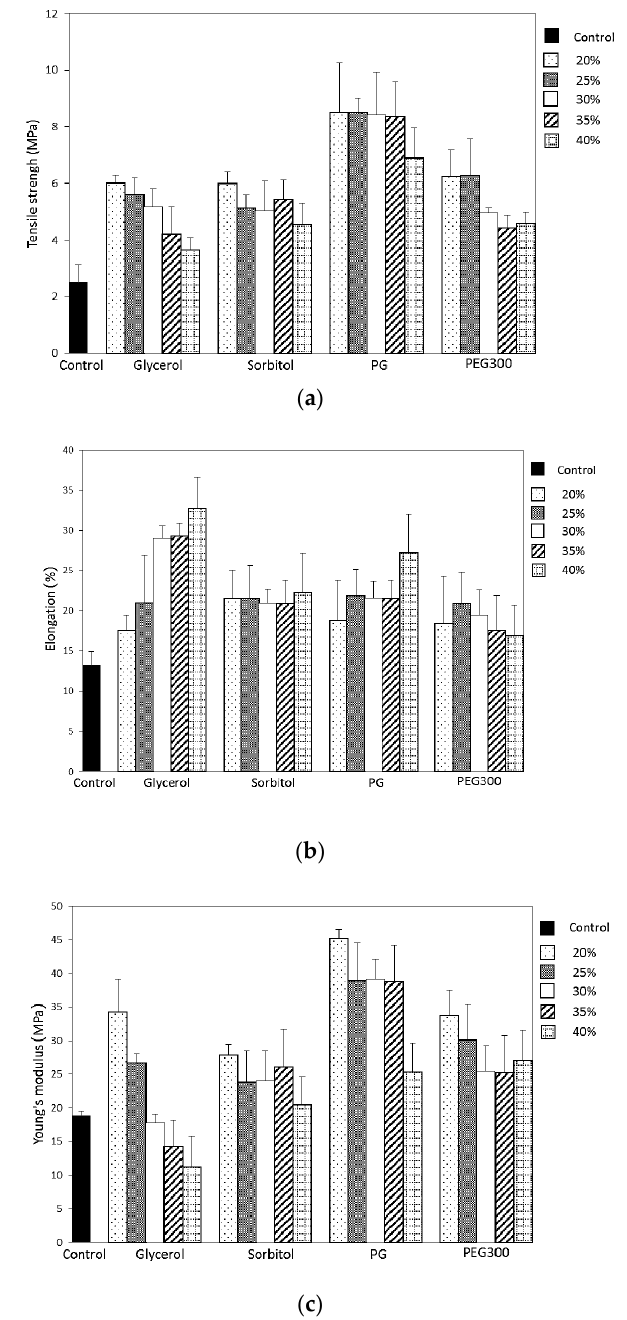
Figure 2. Effect of plasticizer type and concentration on the tensile strength ( a ), elongation (%) at break ( b ) and Young’s modulus ( c ) of LMP films.